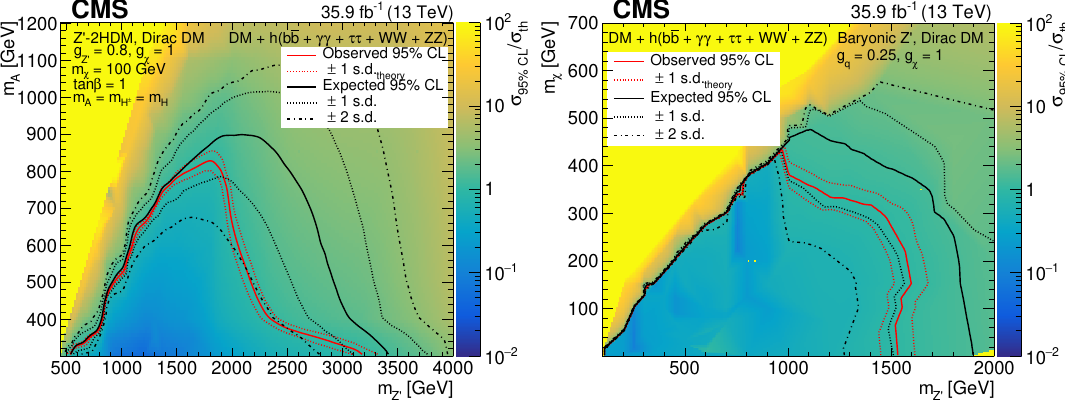
Figure 9 . The upper limits at 95% CL on the observed and expected (cid:27)=(cid:27) m { m planes for the Z 0 -2HDM (left) and baryonic Z 0 model (right), respectively. The region (cid:31) Z 0 enclosed by the contours is excluded using the combination of the (cid:12)ve decay channels of the Higgs boson for the following benchmark scenarios: g m = m = m for the Z 0 -2HDM, and g A H H (cid:6)